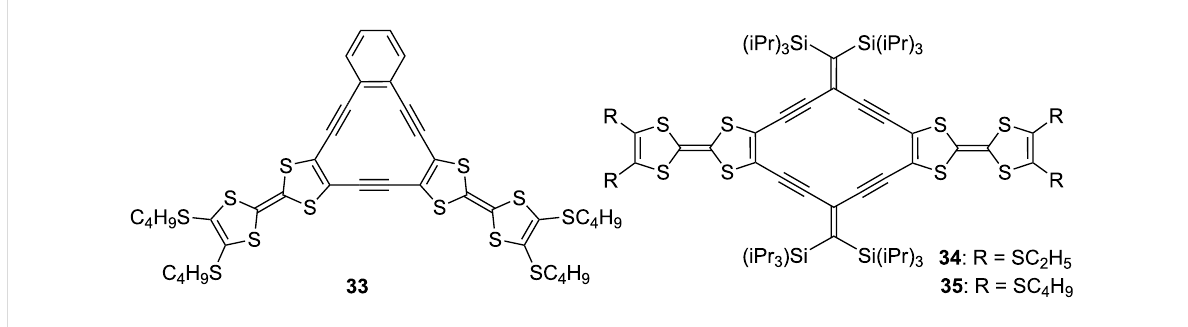
Figure 9: TTF-fused annulene 33 and radiannulenes 34 and 35 .